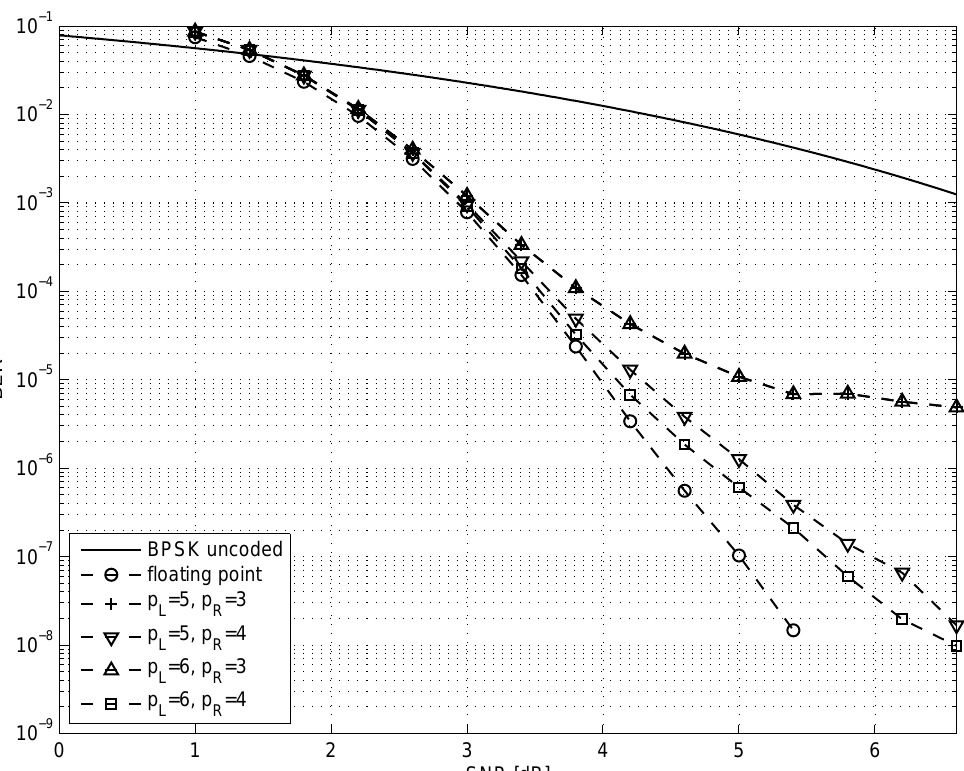
Figure 2. BER performance of the N = 204 LDPC